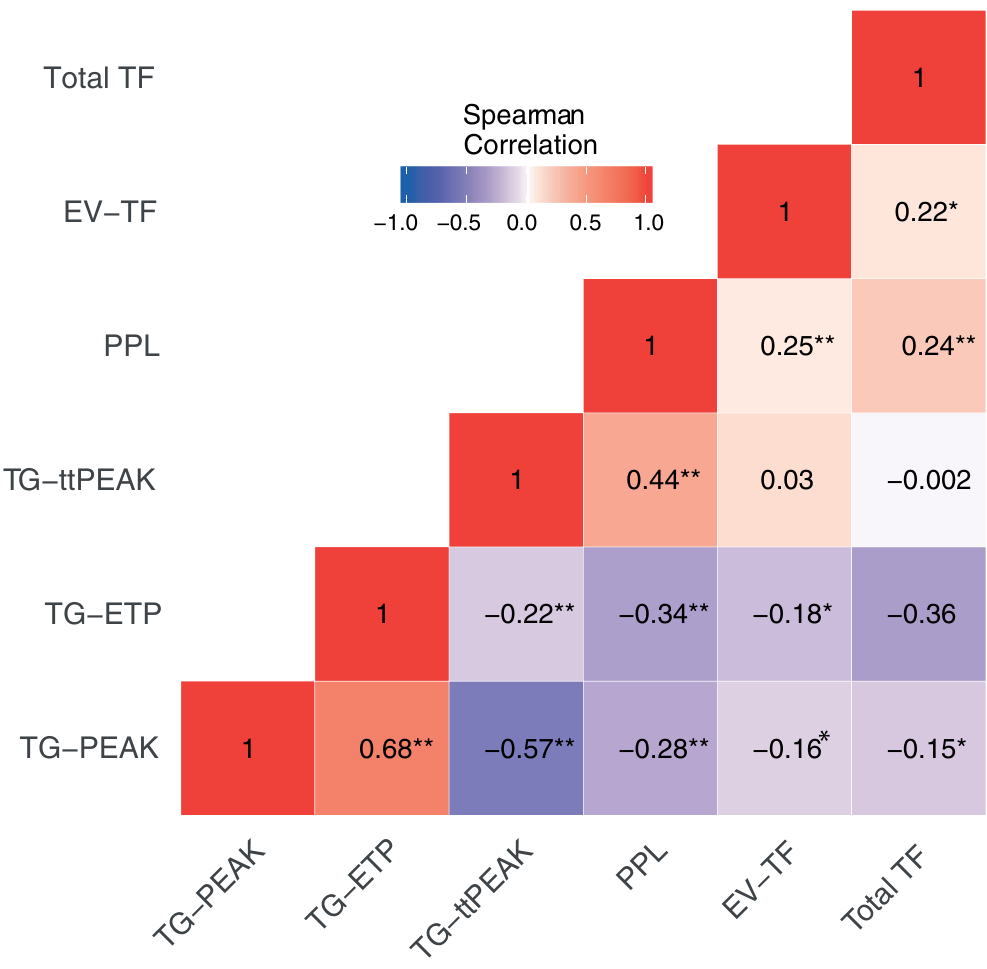
Fig 2. Heat map of biomarker correlations at baseline. TF = Tissue factor; EV-TF = Tissue factor associated with extracellular vesicles; PPL = Procoagulant phospholipids; TG = Thrombin generation; ttPeak = Time to peak; ETP = Endogenous thrombin potential. Please note, TG-ttPeak and PPL are inversely correlated to procoagulant activity, whereas all other biomarkers are positively correlated. � P < 0.05; �� P < 0.001.